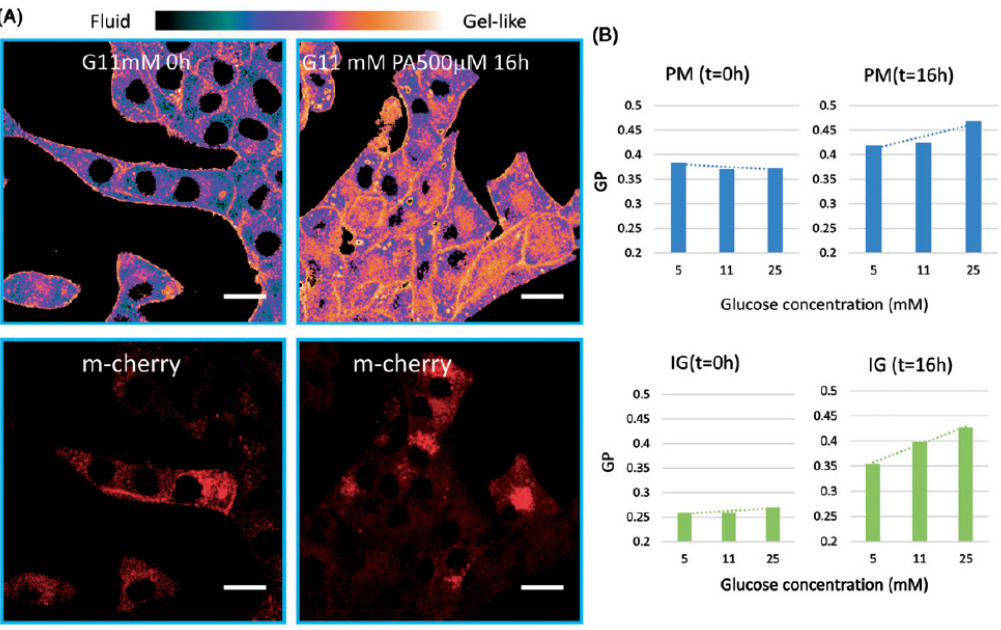
Figure 3. Generalized Polarization (GP) values of the plasma membranes (PM) and insulin granules (IG, mCherry positive organelles) in glucose treated INS-1E cells. ( A ), Representative high-resolution fluorescence images of Laurdan emission for fluidity investigation along with mCherry emission images in INS-1E cells exposed to 11 mM glucose for 32 h and 500 µM palmitic acid (PA) during the last 16 h of incubation. mCherry labeled insulin granules, which have spherical shapes of about 0.5–1 µm diameter. Scale bar is 10 µm. ( B ) Summary of GP values of plasma membrane and insulin granules in cells exposed to different glucose levels without (left) and with palmitic acid (right). Copied with permission from [22].